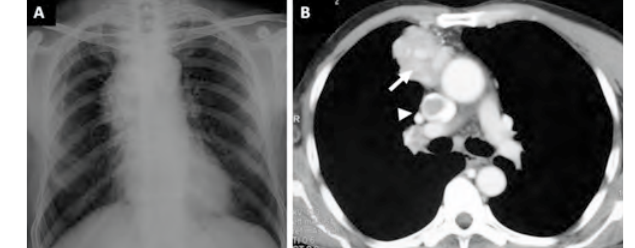
lesion (arrows) in the right side of the neck caudal to the thyroid gland, displacing the trachea to the left. (B) Coronal reformatted image shows the lesion (arrow) is parallel to the sternocleidomastoid muscle and extends into the upper mediastinum.